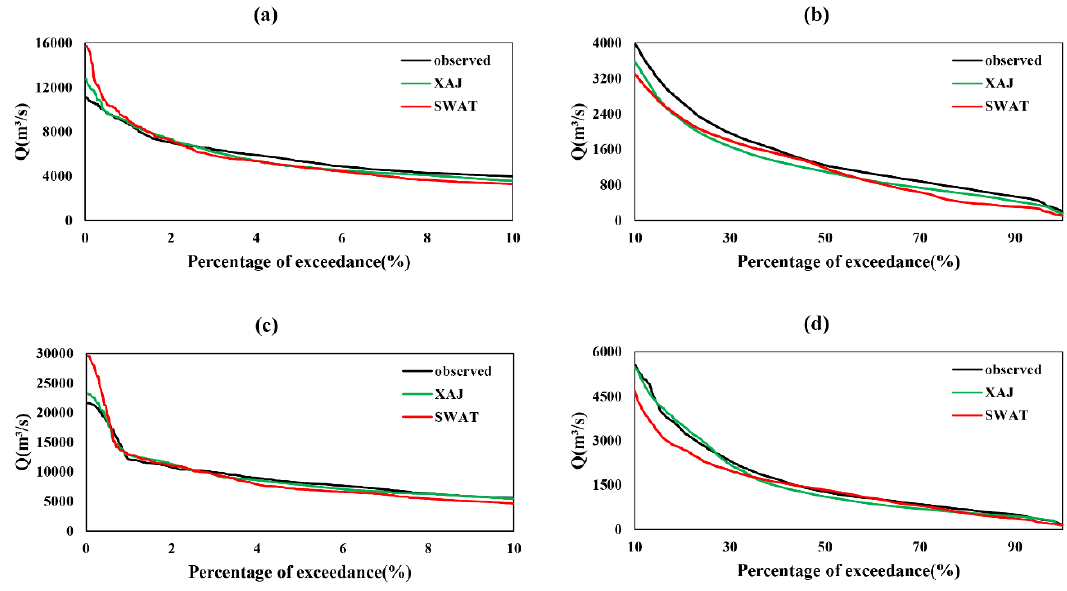
Figure 4. Observed and simulated flow duration curves: ( a ) flow duration curves (FDCs) for high flows during calibration period; ( b ) flow duration curves (FDCs) for medium and low flows during calibration period; ( c ) flow duration curves (FDCs) for high flows during validation period; ( d ) flow duration curves (FDCs) for medium and low flows during validation period.